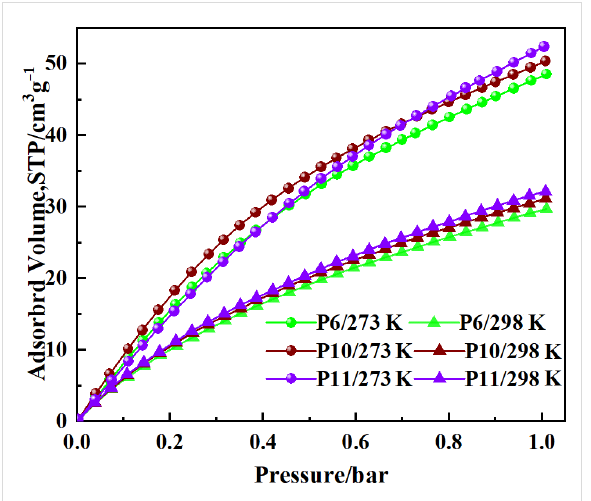
Figure 7: Volumetric CO 2 adsorption isotherms up to 1 bar of P3 , P10 , and P11 .